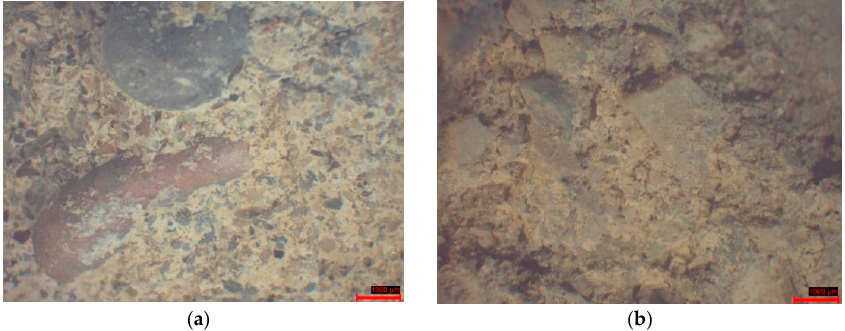
Figure 1. Historic mortars with ( a ) rounded aggregates and ( b ) angular aggregates.